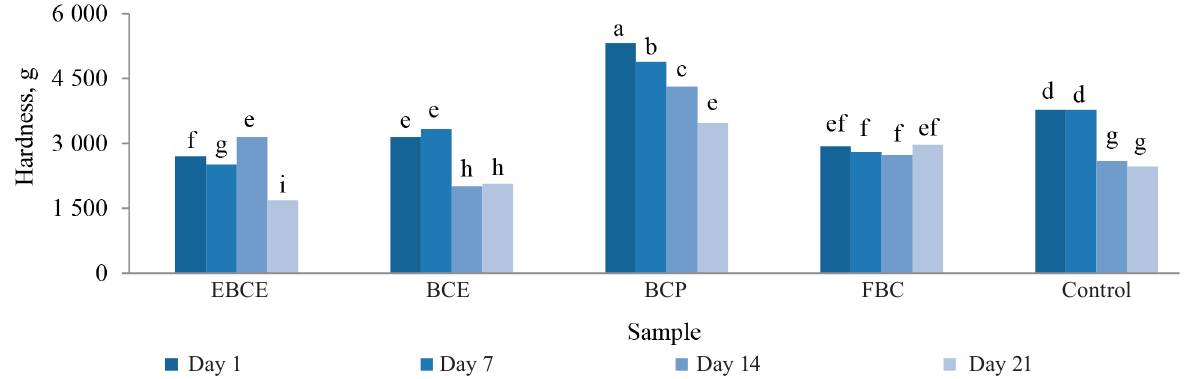
Figure 3 Hardness of kolompeh samples during